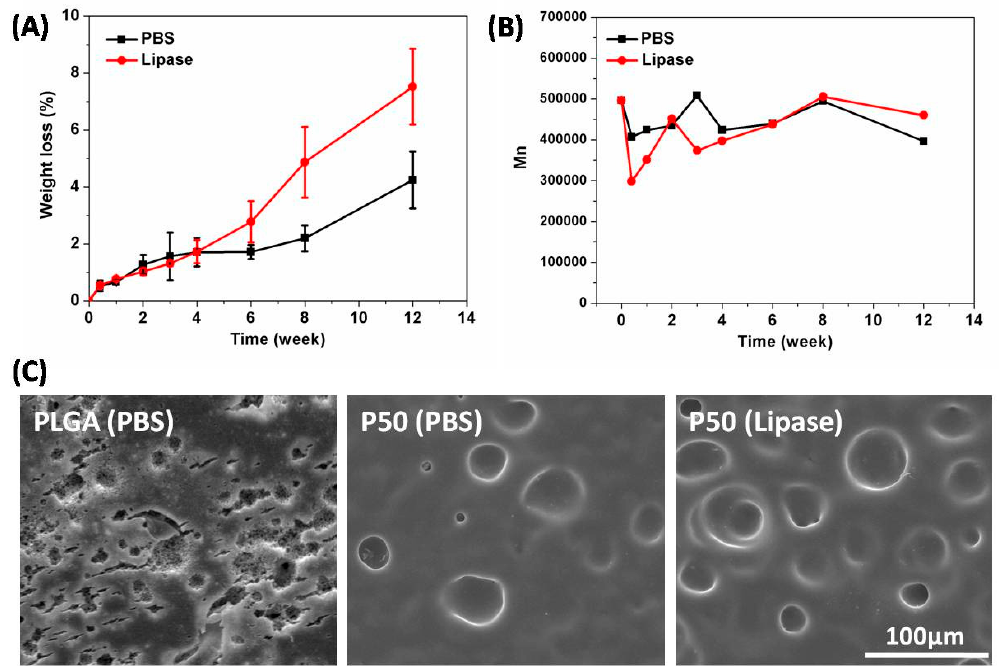
Figure 2. ( A ) Mass loss and ( B ) molecular change of poly (1, 3-trimethylene carbonate) (PTMC) degraded in (PBS) and Lipase (3000 U/L) at 37 °C for different degradation time. ( C ) Surface morphology of poly (lactic-co-glycolic acid) (PLGA) and P50 (PTMC, Mn = 500,000) after being degraded in PBS or lipase for 12 weeks.